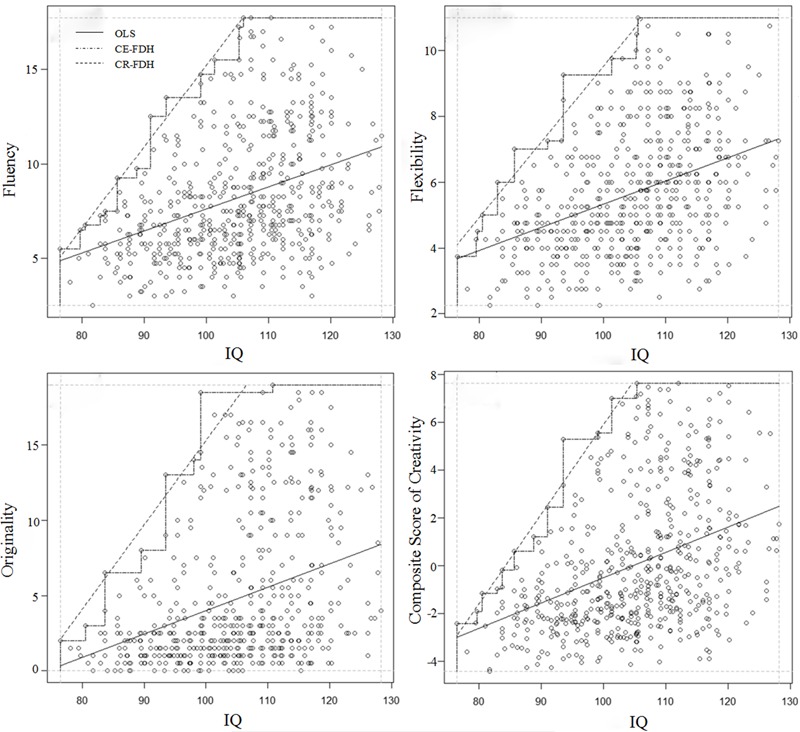
Visualization of the NCA of the relationship between DT and intelligence.